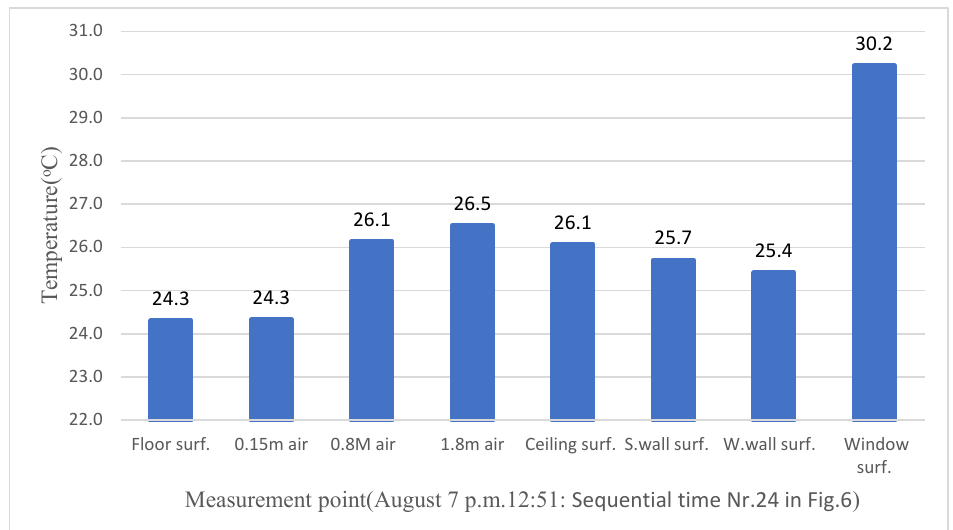
Figure 7. Vertical temperature profile for the room for one instant.